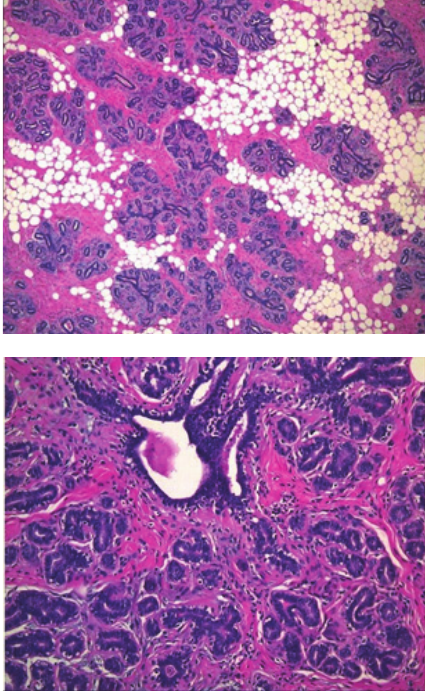
Figure 2: Pathology report: lobular